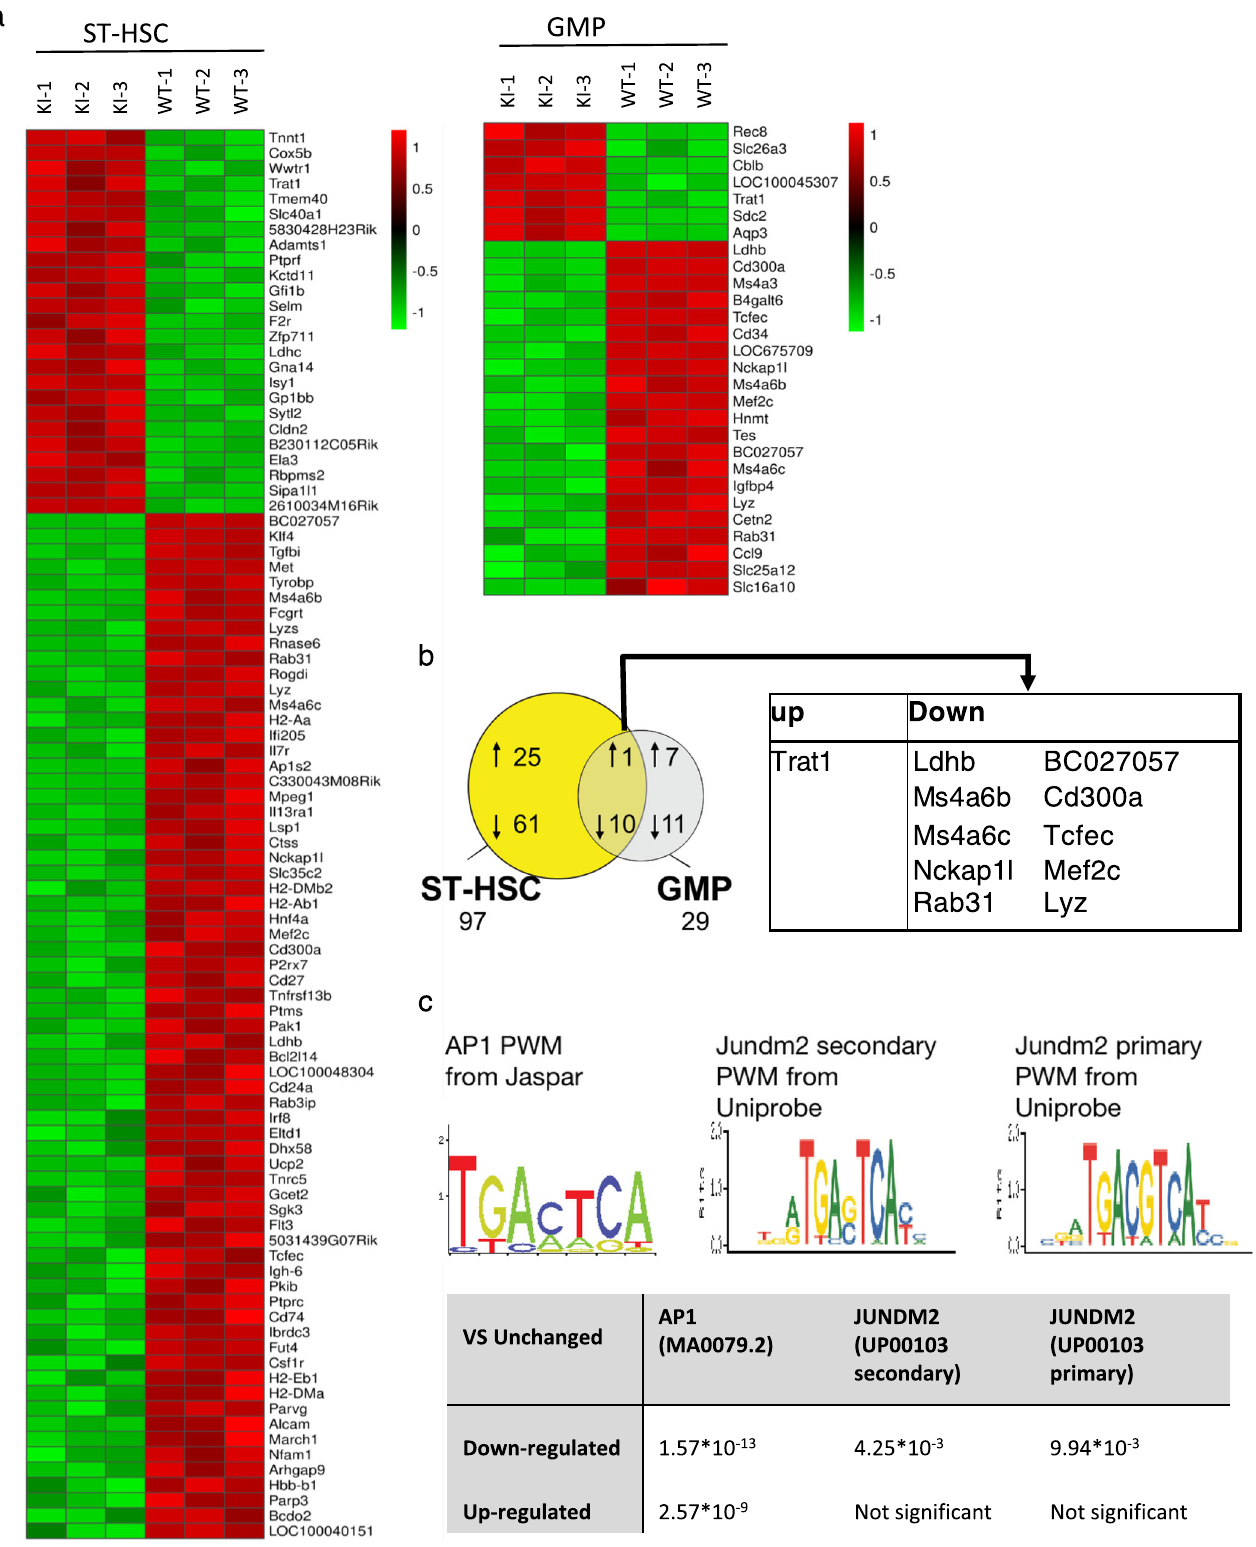
spinoculation at 800 × g for 120 min, 1ml of fresh medium was added to the cells. After 24h, a second spinoculation was carried out. Forty-eight hours after the fi rst transduction, GFP expression in 503 cells was examined by fl ow cytometry. PU.1 expression was determined by Western blotting with anti-PU.1 antibody at 1:1000 dilution (Santa Cruz sc-352). The membrane was stripped with 100 mM, washed with PBS, and incubated with appropriate antibodies in PBS containing 5% calf serum for 30 min on ice in a total volume of 20 μ l. The cell pellet was washed